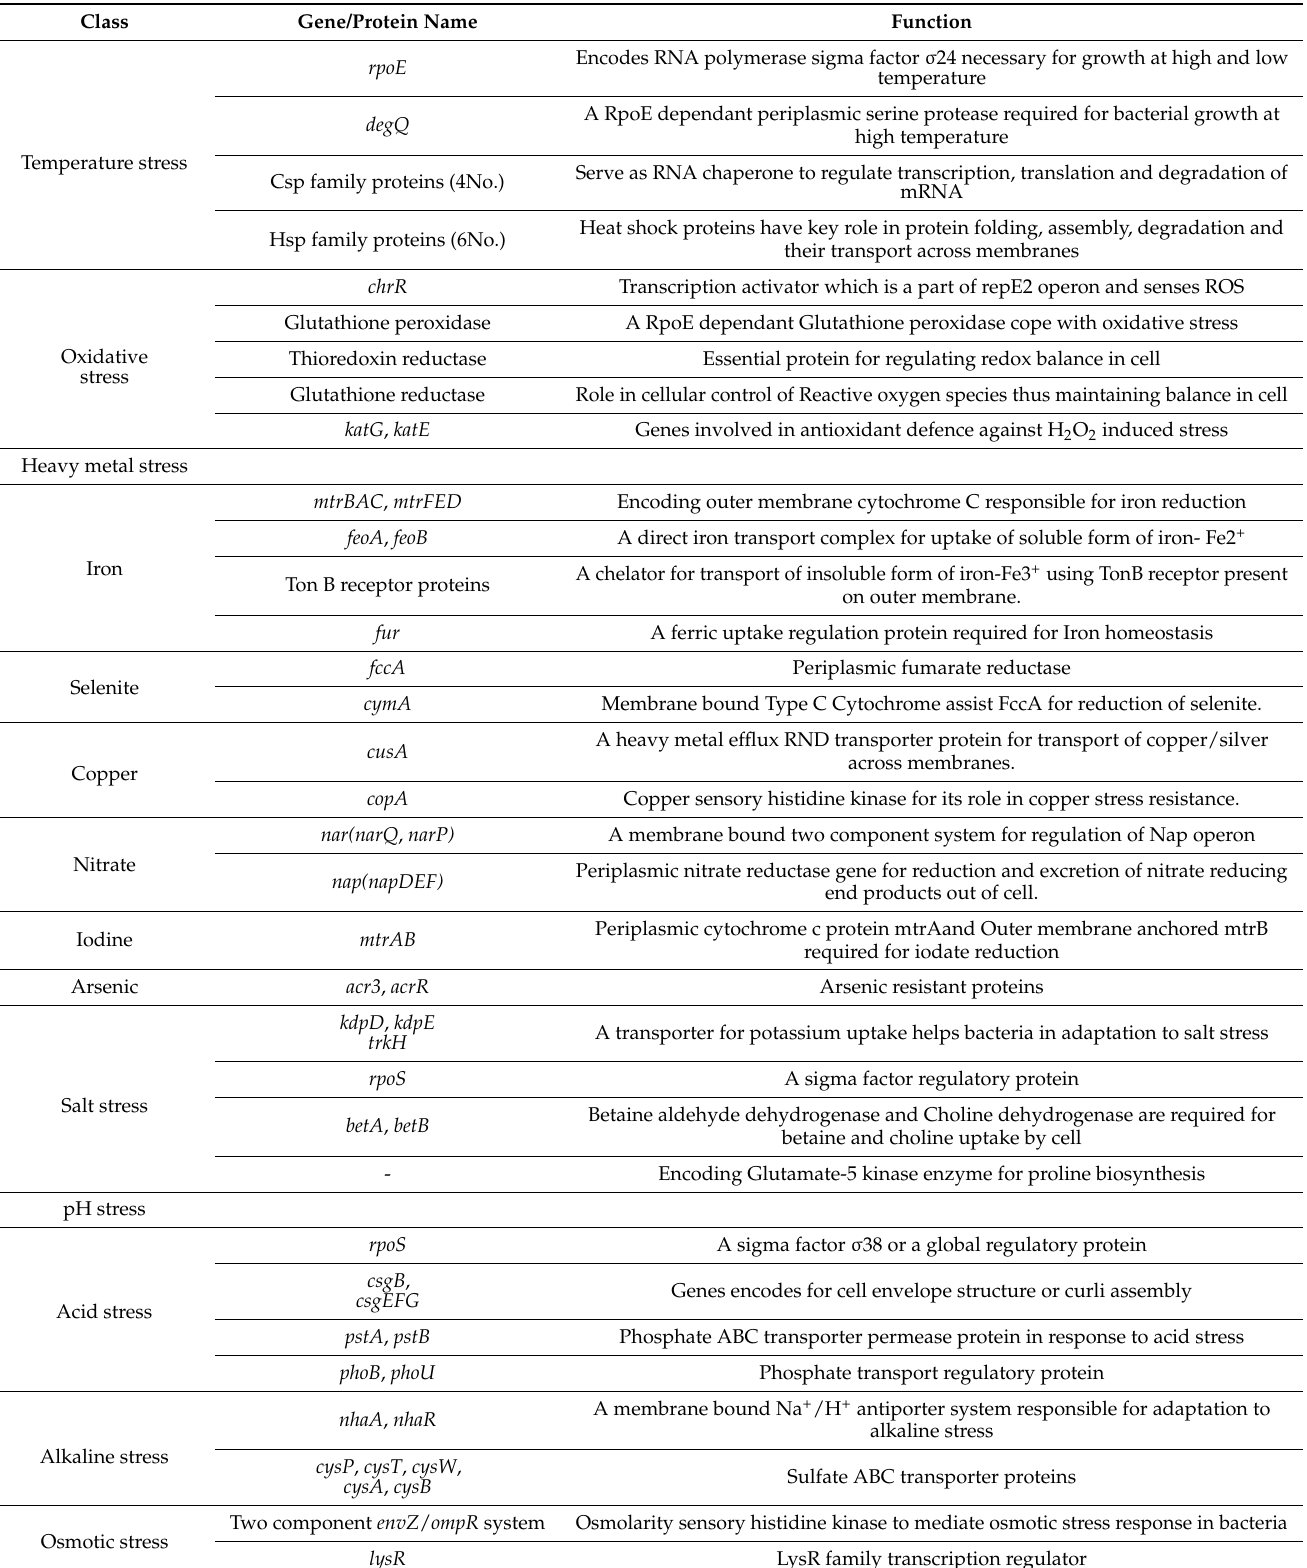
Table 3. Genes associated with stress responses in Shewanella sp. N2AIL